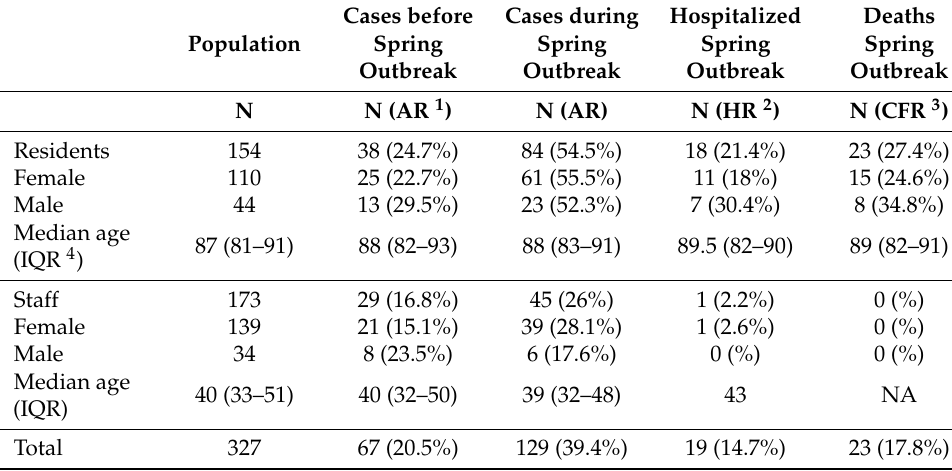
Table 1. Characteristics of COVID-19 cases at the